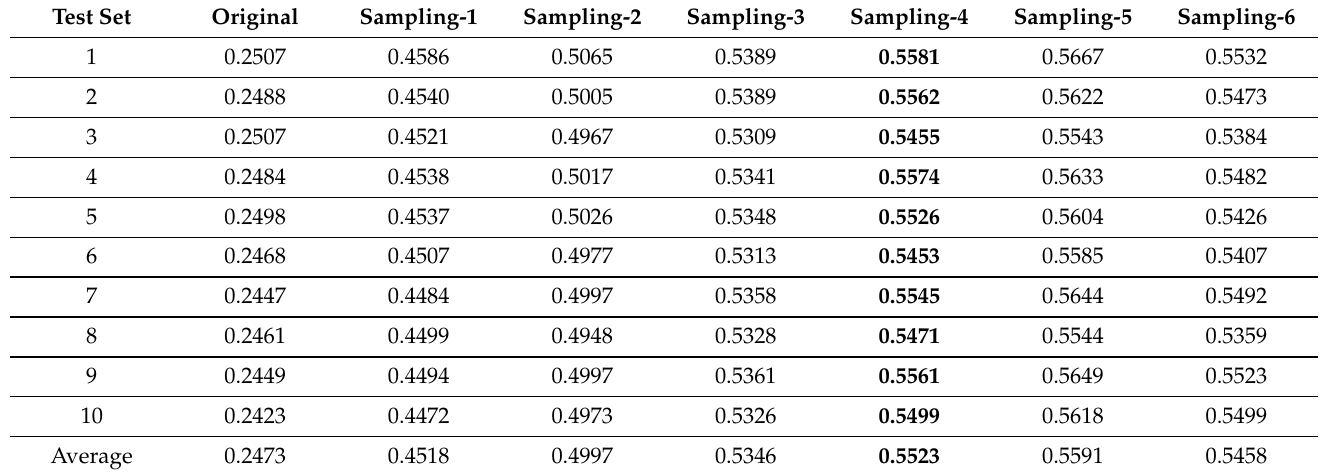
Table 4. Experiments for different undersampling strategies used